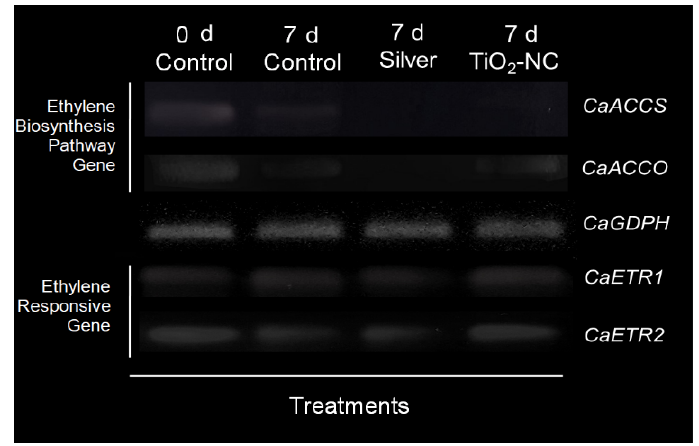
Figure 5. Expression of CaACCS , CaACCO , CaETR1 , CaETR2 genes as compared to CaGAPDH as control gene in Capsicum fruit under silver and TiO 2 -NC with respect to control during 0 d and 7 d of postharvest storage at 25 °C.